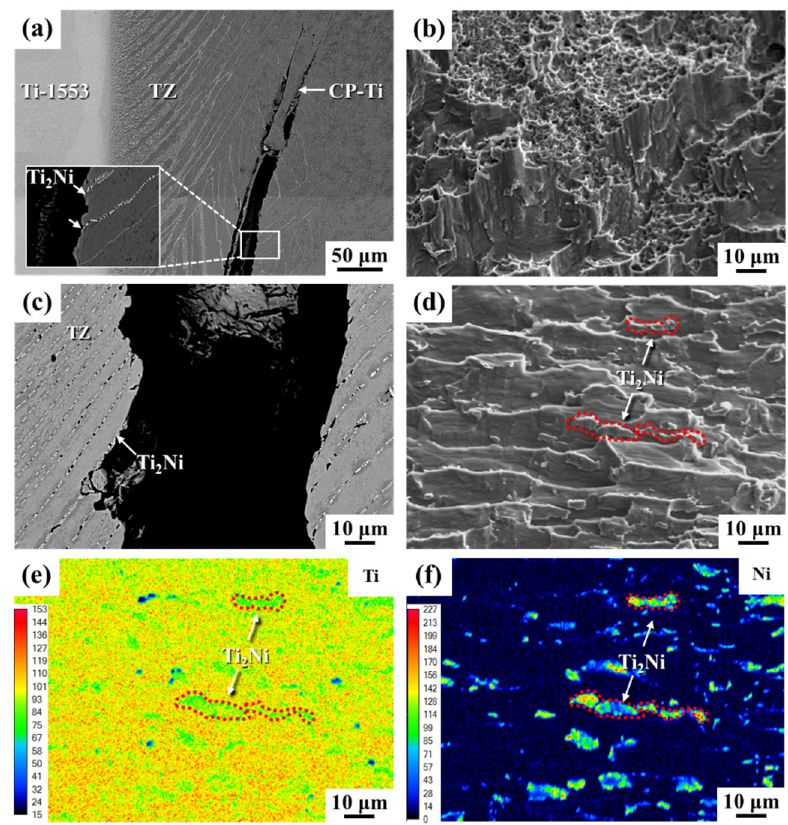
Figure 6. Cross-sectional view of the fractured joint in the SEM-BEI images and shear fracture feature of the brazed joint brazed for ( a , b ) 3 min, ( c , d ) 60 min; ( e , f ) the Ti and Ni element mappings of the fracture surface in